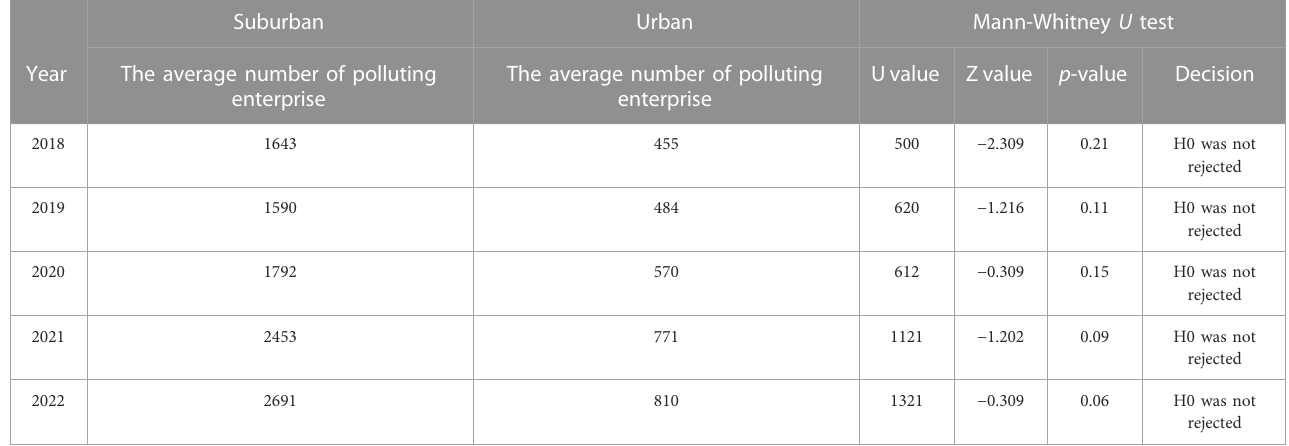
TABLE 3 The number of water-polluting enterprises in urban and suburban areas and the results of the Mann-Whitney U